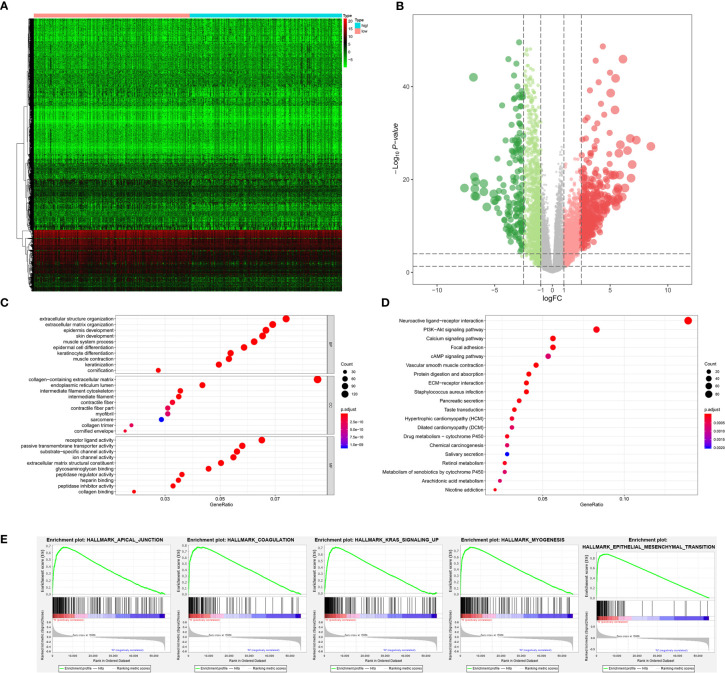
The results of differential expression genes analysis and functional enrichment analysis between low mRNAsi BLCAs and high mRNAsi BLCAs: The heatmap (A) and volcano plot (B) of the differential expressed genes. The GO (C), KEGG (D), and (E) top five GSEA enriched terms for the differential expressed genes.